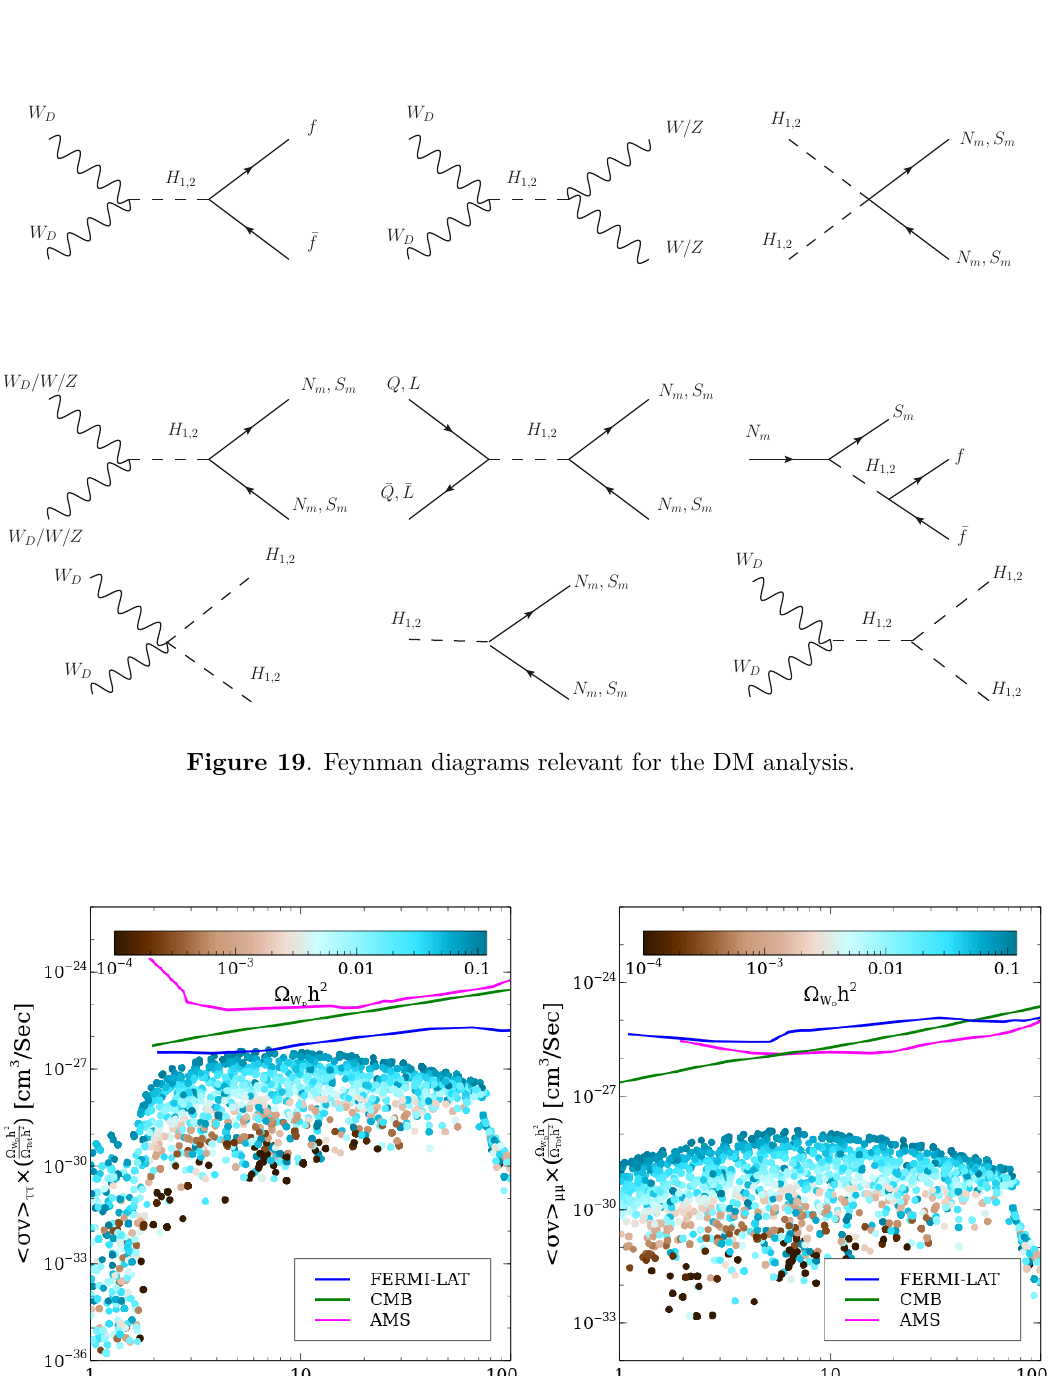
Figure 20 . Allowed parameter space satisfying 0 . 01 ≤ Ω DM h 2 ≤ 0 . 12 in the M W (Ω Ω ) h σv i (left) and M – (Ω Ω ) h σv i (right) planes. Here, Ω W D / Tot ττ W D W D / Tot µµ is total DM relic density today. Various indirect detection bounds are overlaid with solid lines; see text for detailed explanation. The colour of the points represents the WIMP DM relic